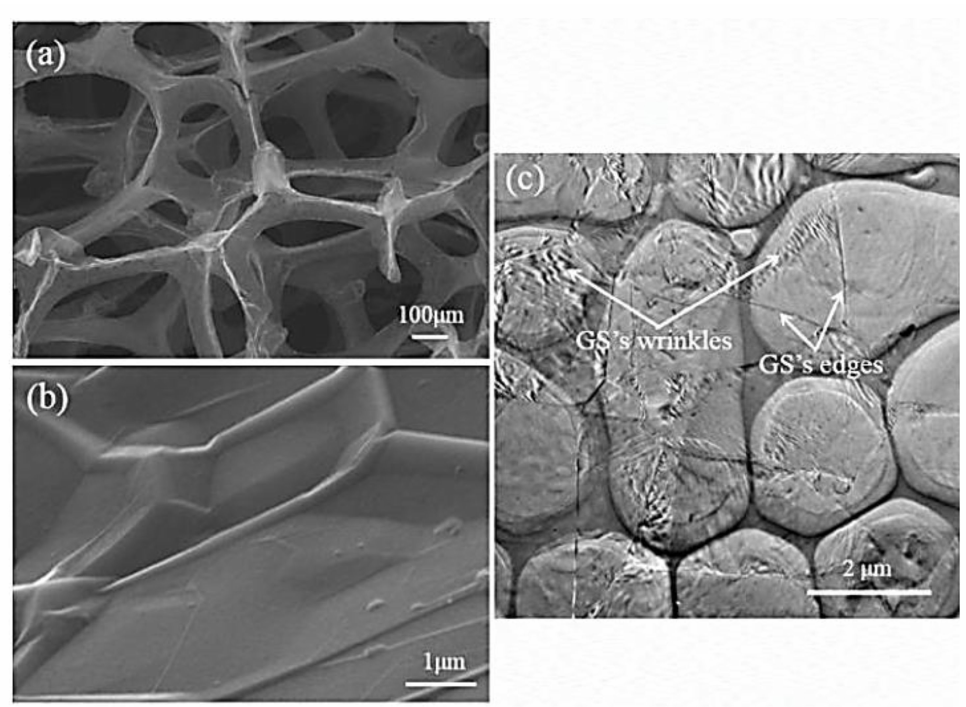
Figure 6. Scanning electron microscopy images of ( a ) graphene nanofoam; ( b ) graphene sheet; and ( c ) transmission electron microscopy image of graphene sheet. PDMS = poly(dimethyl silox- ane); GF/PDMS = /poly(dimethyl siloxane); GS/PDMS = poly(dimethyl siloxane). Reprinted with permission from Ref. [86]. 2015, Elsevier.